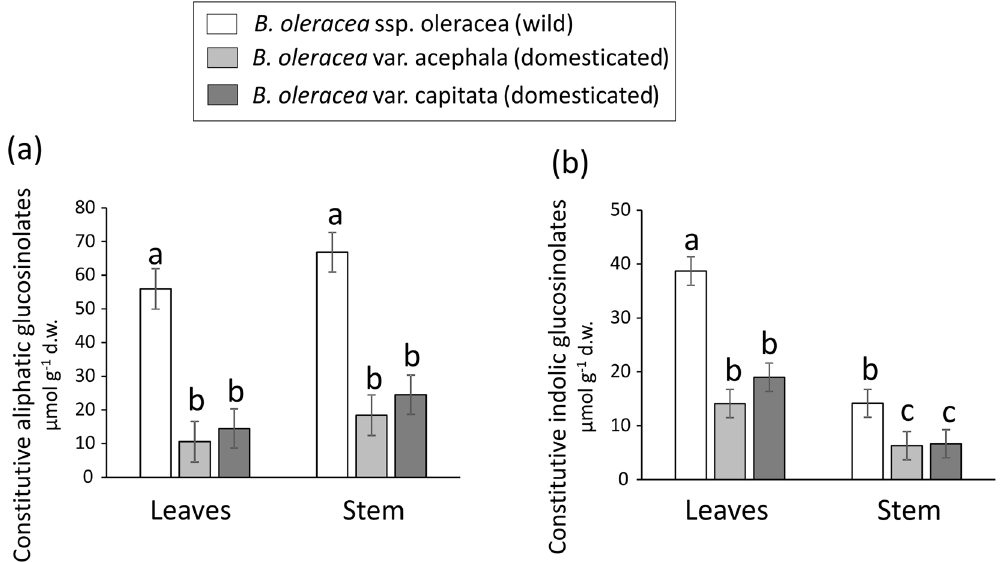
Figure 5. Effects of plant domestication on leaf vs. stem constitutive chemical defences. Constitutive concentrations of (a) aliphatic and (b) indolic glucosinolates in leaves and stems of wild cabbage ( Brassica oleracea ssp. oleracea) and two domesticated varieties of this species ( B . oleracea var. acephala and B . oleracea var. capitata). Bars are least square means ± s.e.m. (N = 36 replicate plants per plant line). Different letters indicate significant ( P < 0.05) differences between plant lines (see Table 3 for statistics). d.w. = dry weight.